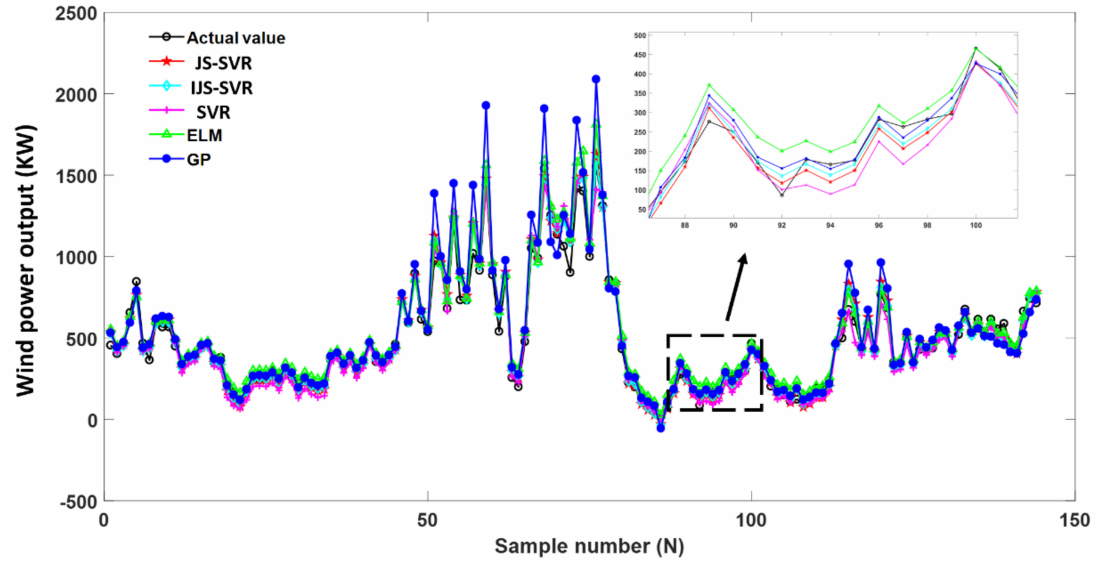
Figure 4. The prediction results of each prediction model in spring.